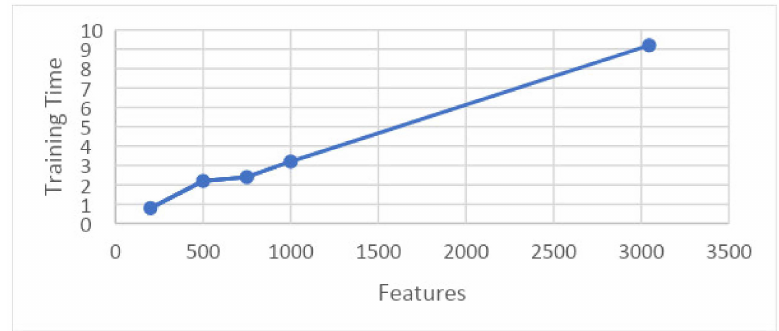
Figure 20. Graph showing training time and features on 5-fold.